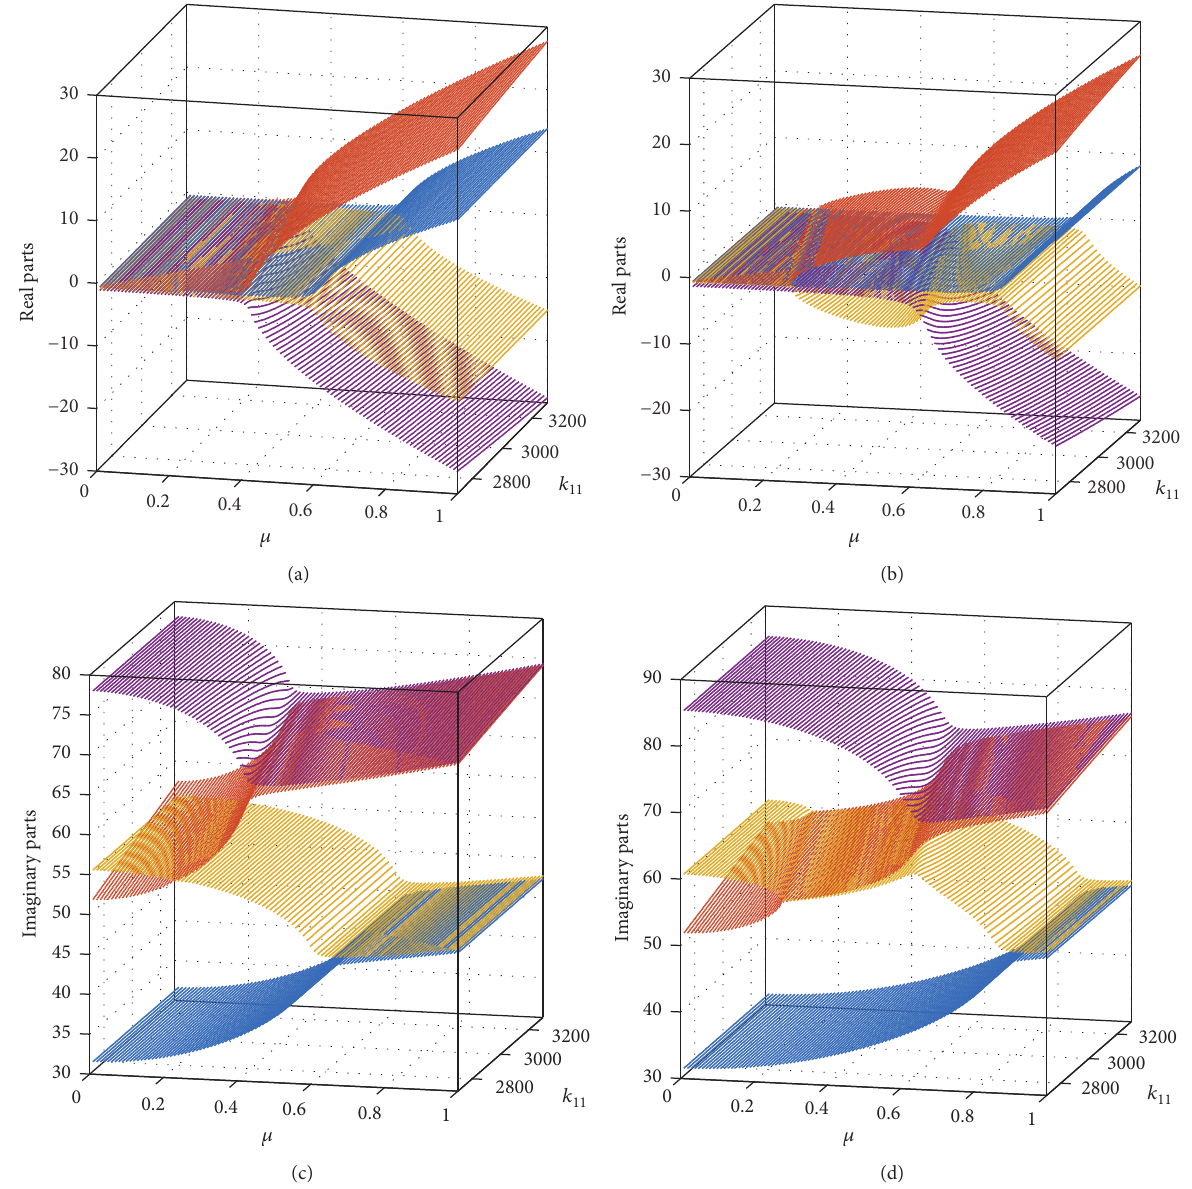
Figure 2: Evolution of real parts (a, b) and imaginary parts (c, d) of eigenvalues versus 𝜇 and 𝑘 11 for configurations 1 (a, c) and 2 (b, d).